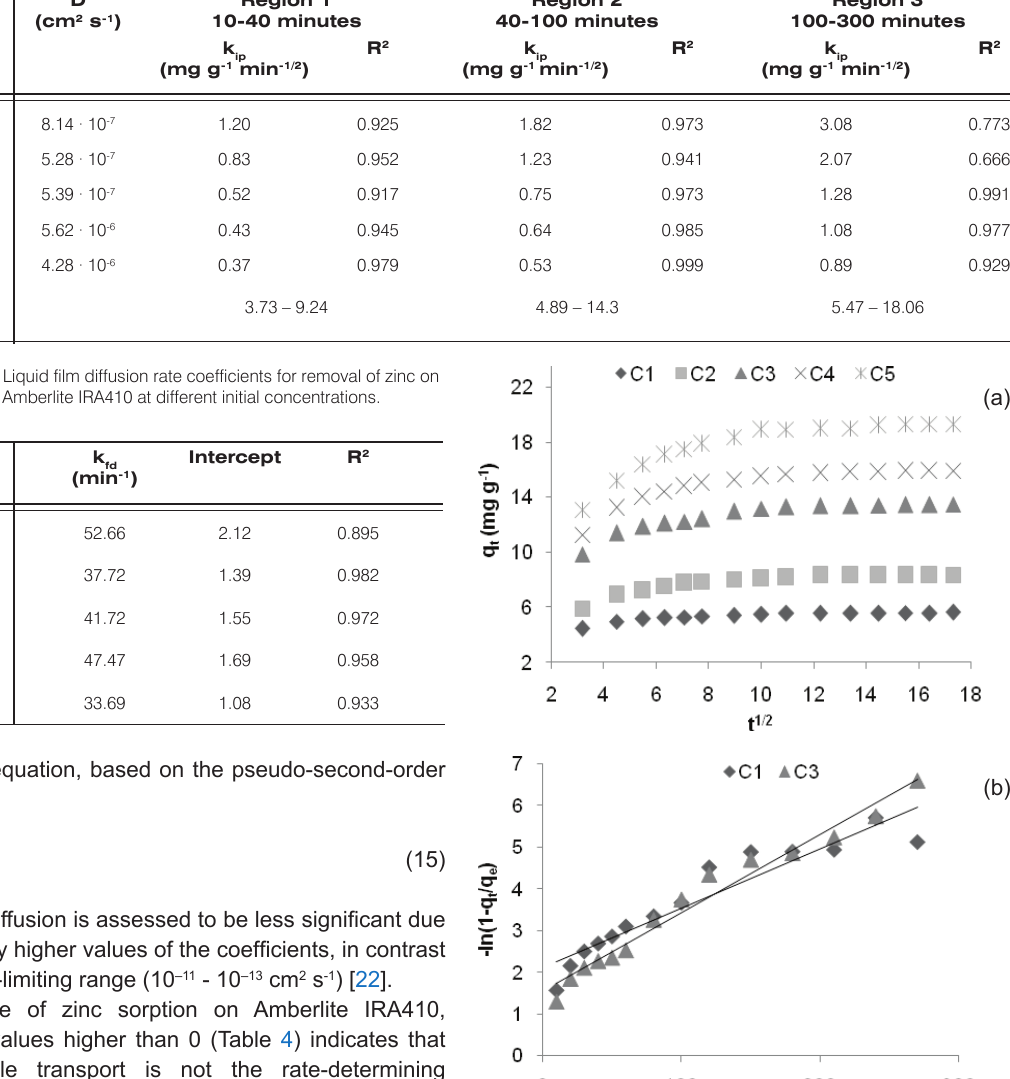
Table 4. Intra-particule diffusion rate coefficients for zinc sorption on Amberlite IRA410 at different initial concentrations. C 0 (mg L -1 )